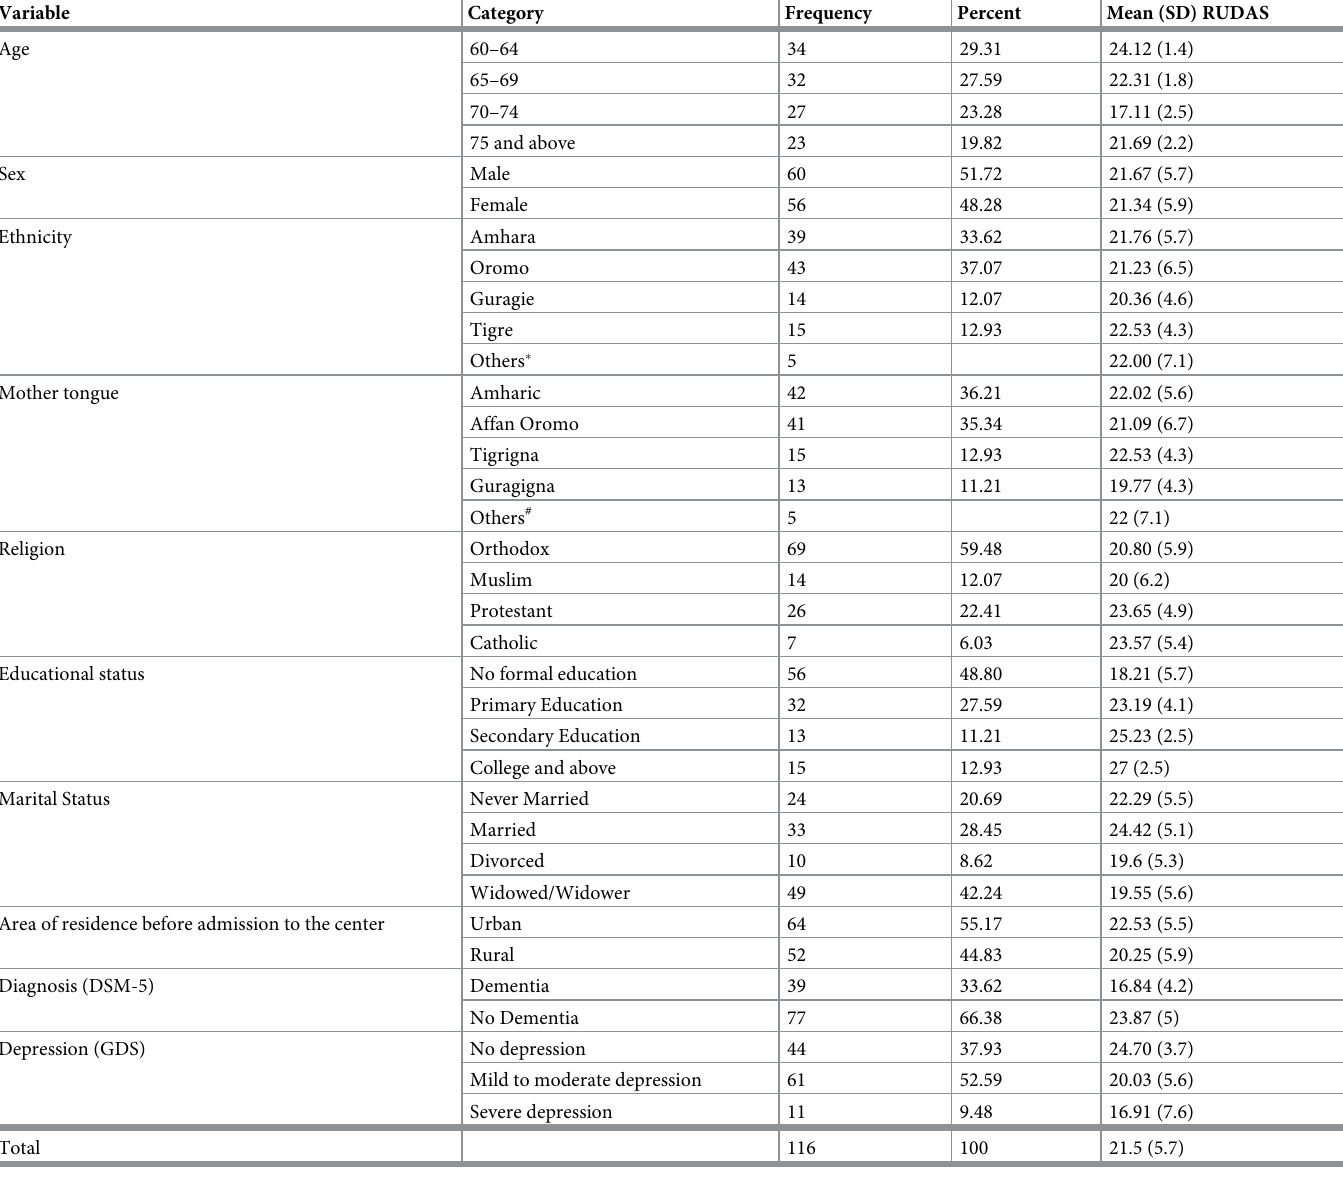
Table 1. Socio demographic and clinical characteristics with mean scores on RUDAS of the study